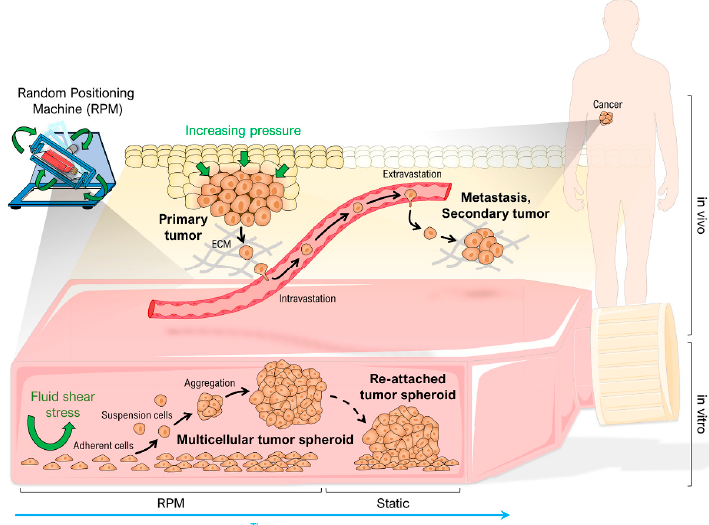
Figure 1. Comparison of metastasis in vivo and random positioning cell culture with adherent growing cancer cells in vitro. Modified from [19]. Parts of the figure were drawn by using pictures from Servier Medical Art, licensed under a Creative Commons Attribution 3.0 Unported License (https://creativecommons.org/licenses/by/3.0/, accessed on 12 February 2023).